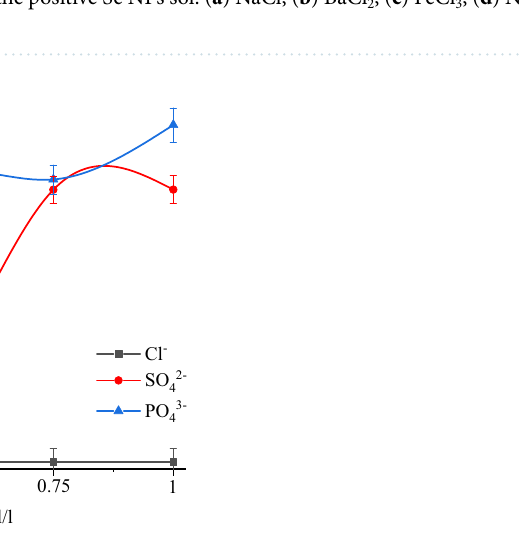
Figure 10. Dependencies of the average hydrodynamic radius of positive Se NPs sol on levels of Cl − , SO 42− and PO 43−